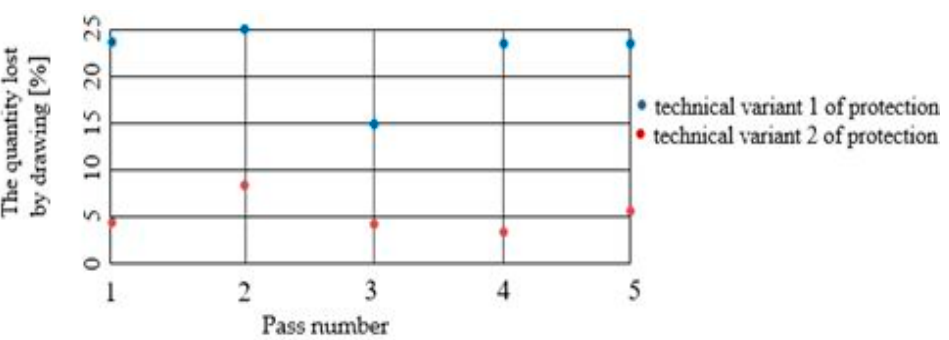
Figure 10. The evolution of the quantity of the protector layer lost in the steel wiredrawing process.